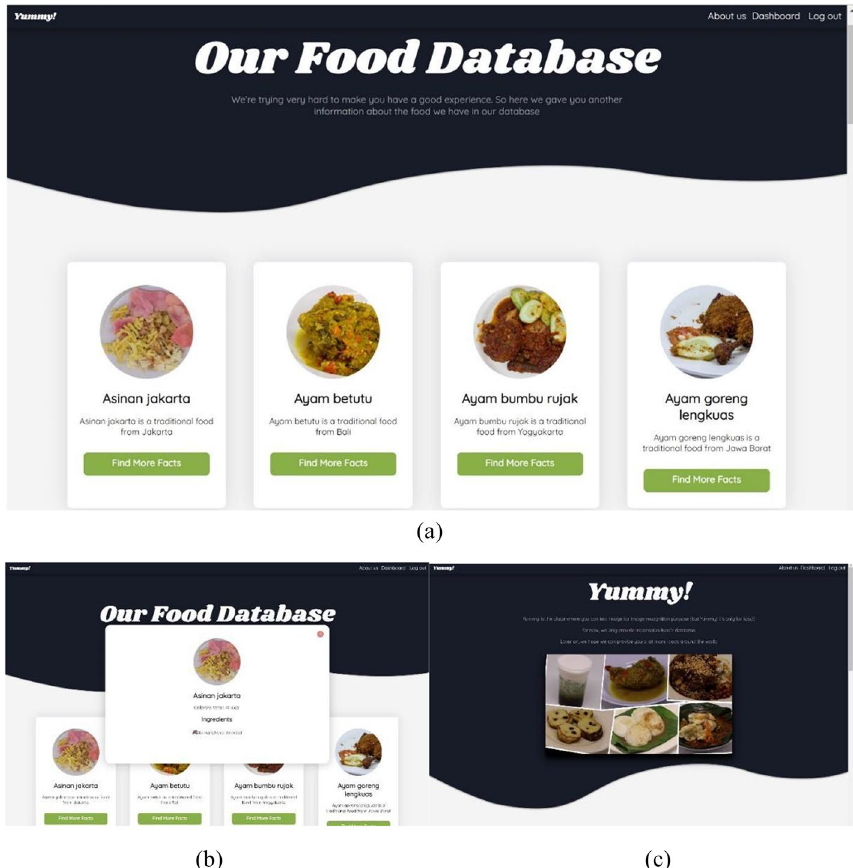
Fig. 2 Conceptual interfaces a food database, b food details, c